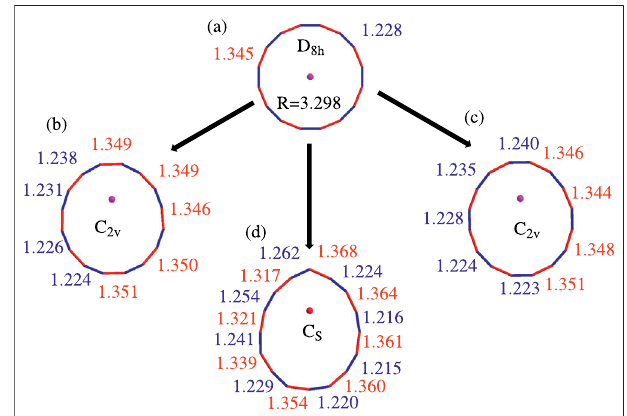
FIGURE 1 | Computed optimized geometries of the ground state of neutral Li@C 16 . (A) In D 8 h symmetry (at EA-EOM-CCSD/cc-pVTZ level). (B) In C 2 v symmetry with off-center Li + towards the single C-C bond (at EA-EOM- CCSD/cc-pVTZ level). (C) In C 2 v symmetry with off-center Li + towards the triple C-C bond (at EA-EOM-CCSD/cc-pVTZ level). (D) In C s symmetry with off-center Li + towards one carbon atom (at ω B97XD/cc-pVTZ level). The bonds colored in red and blue are the single and triple C-C bonds,